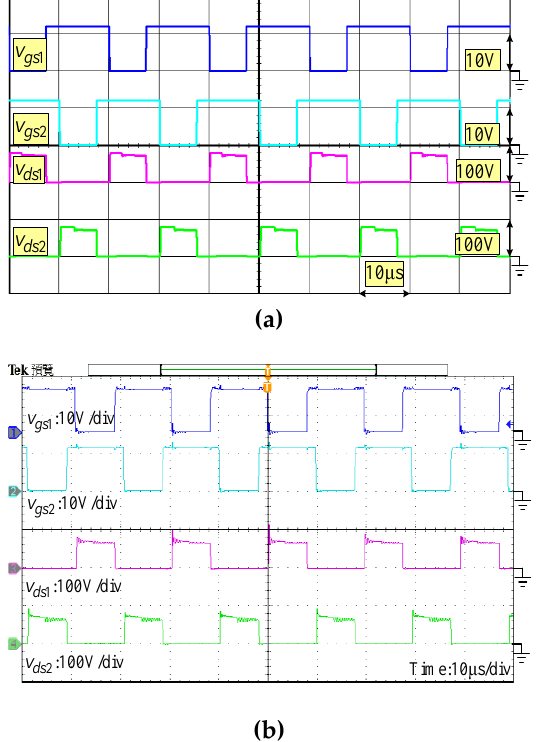
V and V . ( a ) Simulated results. ( b ) Experimental results. o in